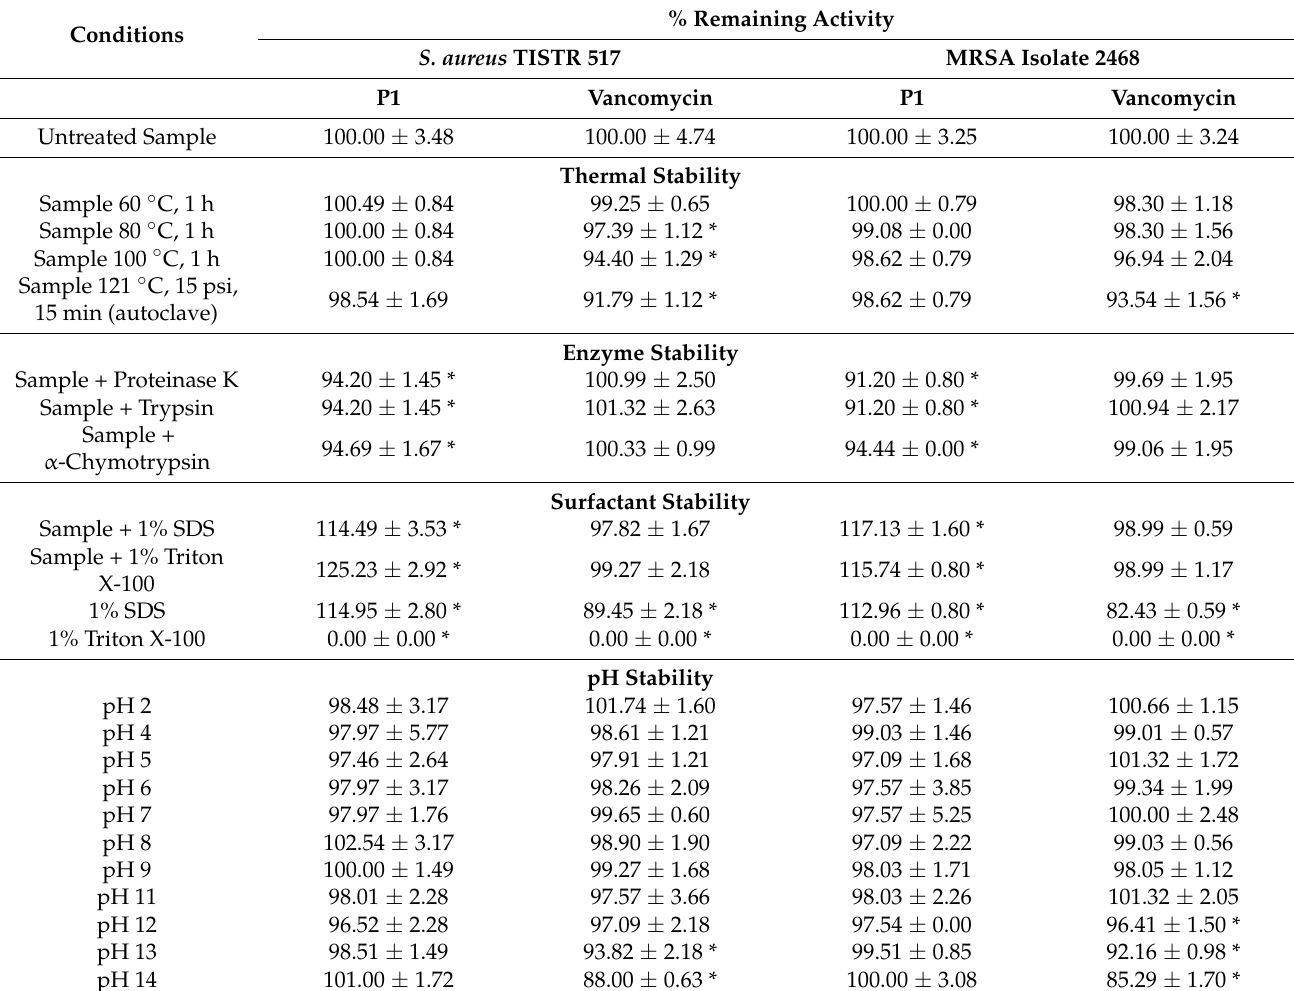
Table 6. Stability studies of anti-MRSA peptide (P1) when compared to vancomycin in various